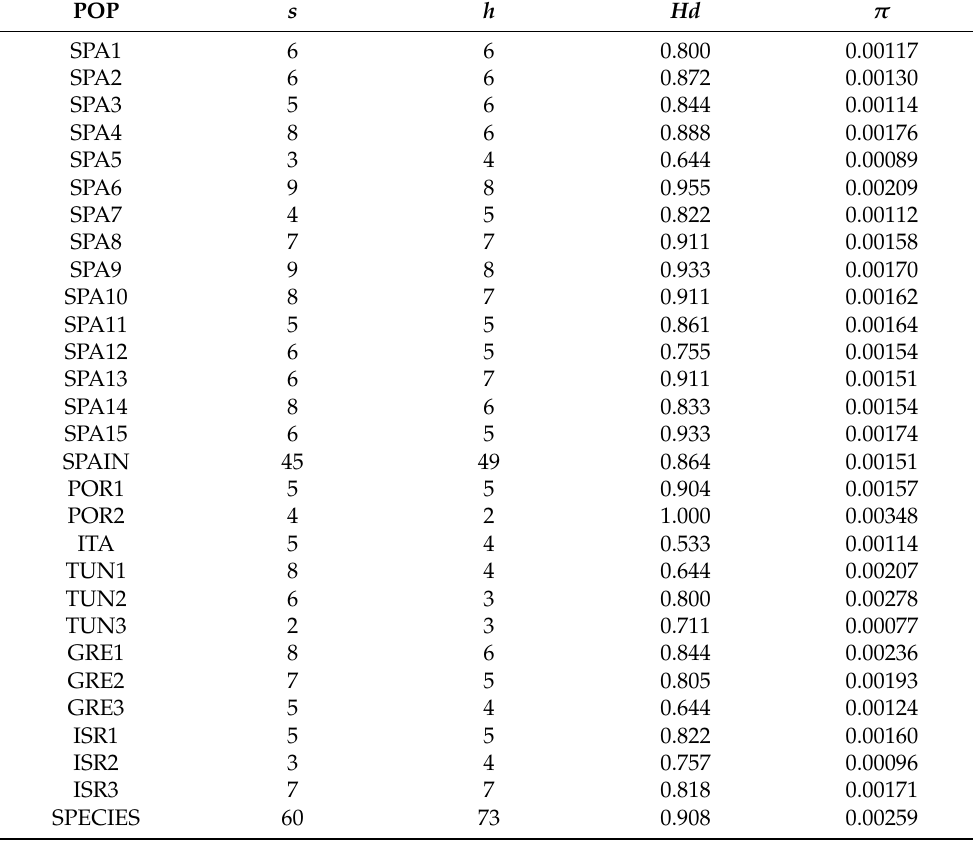
Table 2. Genetic diversity parameters of mtDNA cytochrome oxidase subunit I ( COI ) from the B. oleae populations analysed. S , the number of polymorphic sites; h , the number of haplotypes found; Hd , haplotype diversity; π , nucleotide diversity. SPA, Spain; POR, Portugal; ITA, Italy; TUN, Tunisia; GRE, Greece; ISR, Israel; SPAIN, the 15 Spanish samples together. POP